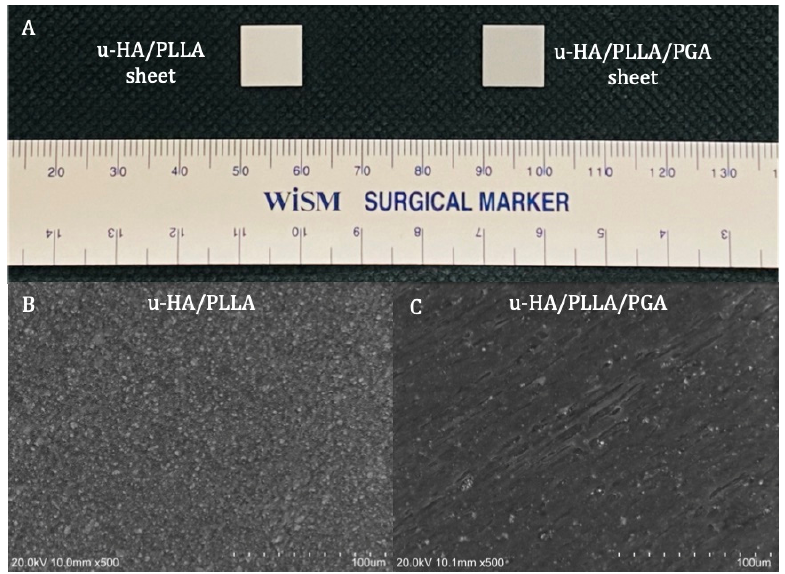
Figure 1. Materials. ( A ) Examples of a u-HA/PLLA ( left ) and u-HA/PLLA/PGA ( right ) sheets. ( B ) Scanning electron microscope image of u-HA/PLLA material. ( C ) Scanning electron microscope image of u-HA/PLLA/PGA material.